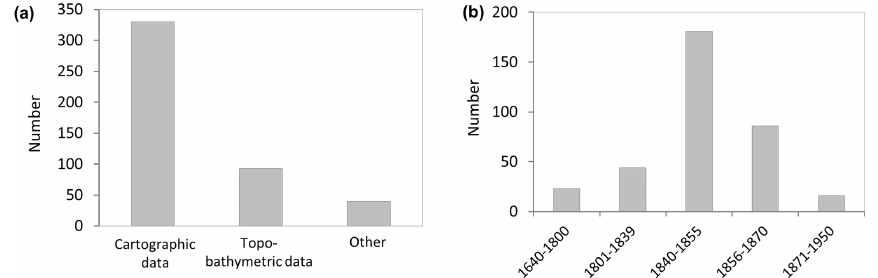
Figure 4. (a) Number of archive data items compiled in this study. “Other” corresponds to plans < 1:1000, long profiles of the Swiss Rhône, and books. (b) Temporal extent of cartographic and topo-bathymetric data.